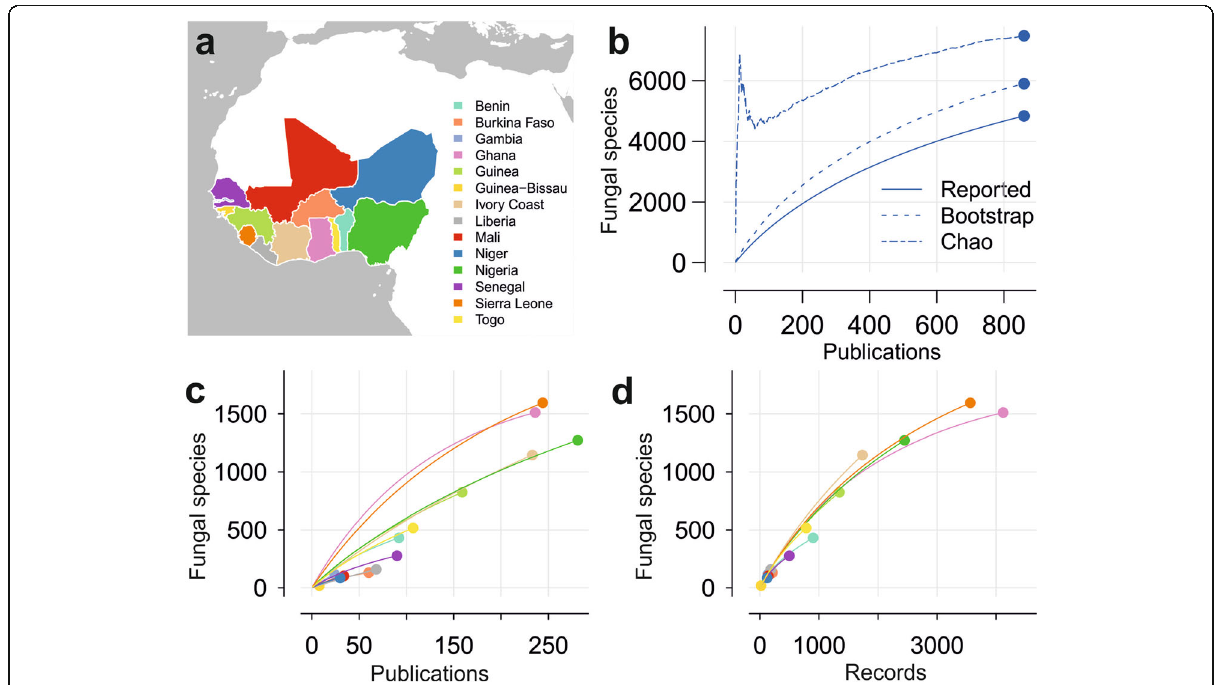
Fig. 1 Numbers of fungal species and estimations for fungal species richness in West Africa and West African countries. a Countries of West Africa considered for the present analysis. b Accumulation curve of numbers of fungal species known for West Africa reported by publications. Dashed lines show the accumulation of species as calculated with the richness estimators Bootstrap or Chao. c Accumulation curves of numbers of fungal species known for West African countries based on increasing numbers of publications that were analysed. Colours indicate the countries as shown in Fig. 1a. d Accumulation curves of numbers of fungal species known for West African countries based on increasing numbers of records. Colours indicate the countries as shown in Fig.